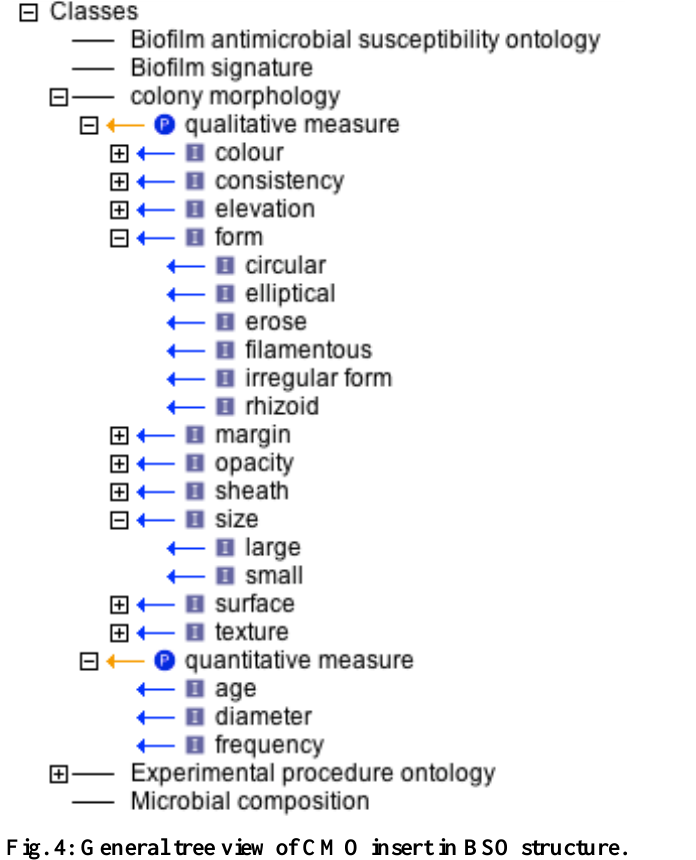
Fig. 4: General tree view of CMO insert in BSO